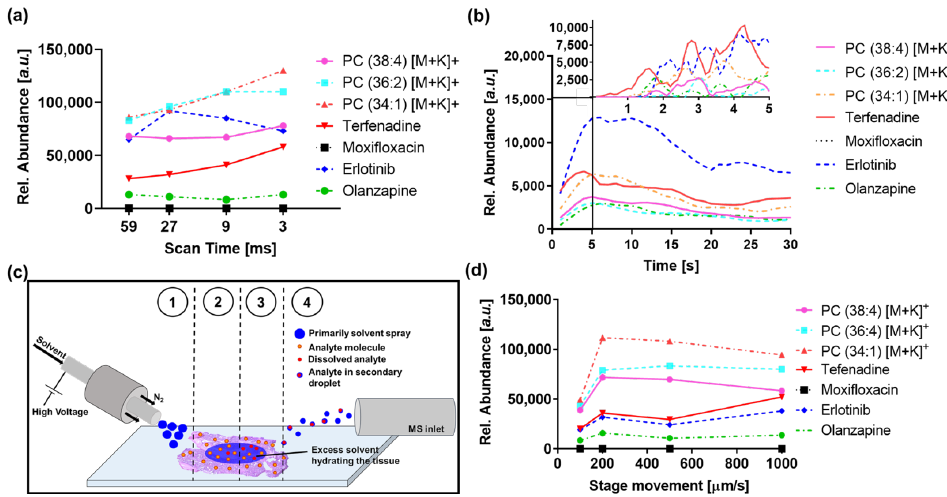
Figure 1. ( a ) Relative abundances of endogenous compounds and cassette-dosed drugs over dwell times of 59, 27, 9, and 3 ms/transition. PC-phosphatidylcholine. Data represent the mean of 3 randomly chosen ROIs per data-point. ( b ) Kinetics experiment monitoring the same transitions were performed with a dwell time of 59 ms resulting in a scan rate of 1 scans/s. The zoomed panel shows the static kinetics of the first 5 s acquired with a dwell time of 3 ms resulting in a scan rate of 10 scans/s. All data represent the mean of 3 independent experiments. ( c ) Schematic visualization of the steps involved in the desorption/ionization process: (1) Re-hydration of the tissue section through primarily charged electrospray solvent, (2) Accumulation of excess spray solvent in the tissue section and dissolution of analytes, (3) Analytes are increasingly dissolved in excess spray solvent, and (4) desorbed in secondary droplets which enter the mass spectrometer. For easier accessibility of the schematic not visualized is step (5), depletion of analytes from target tissue. ( d ) Desorption dynamics for the monitored compounds for stage movement of 100, 200, 500, and 1000 μm/s acquired at a constant dwell time of 9 ms resulting in a scan rate of 5 scans/s. Data represent the mean of 3 independent experiments.